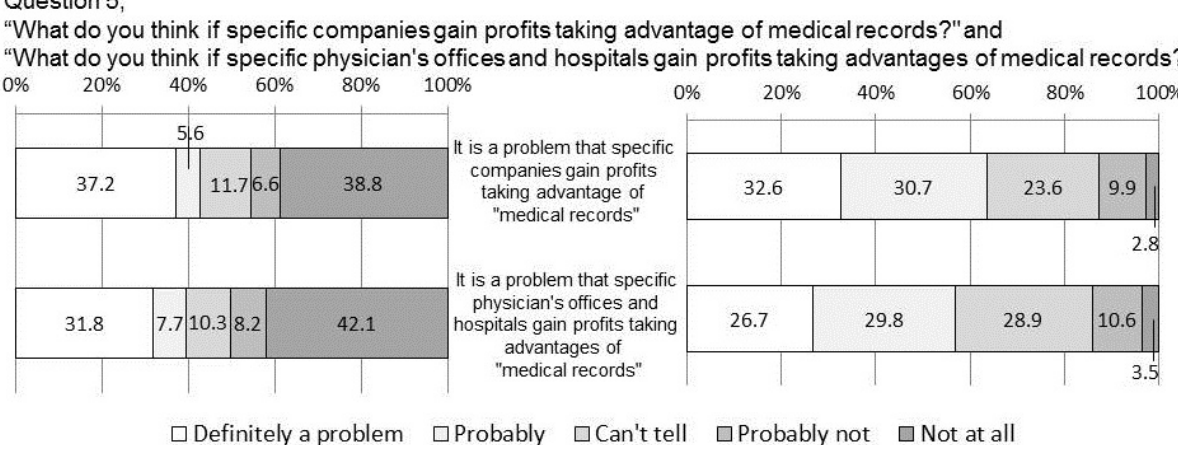
Figure 4. Do you want your medical records to be compiled into one file as lifelong medical records? How about with 5% off on medical cost? with 5% insurance